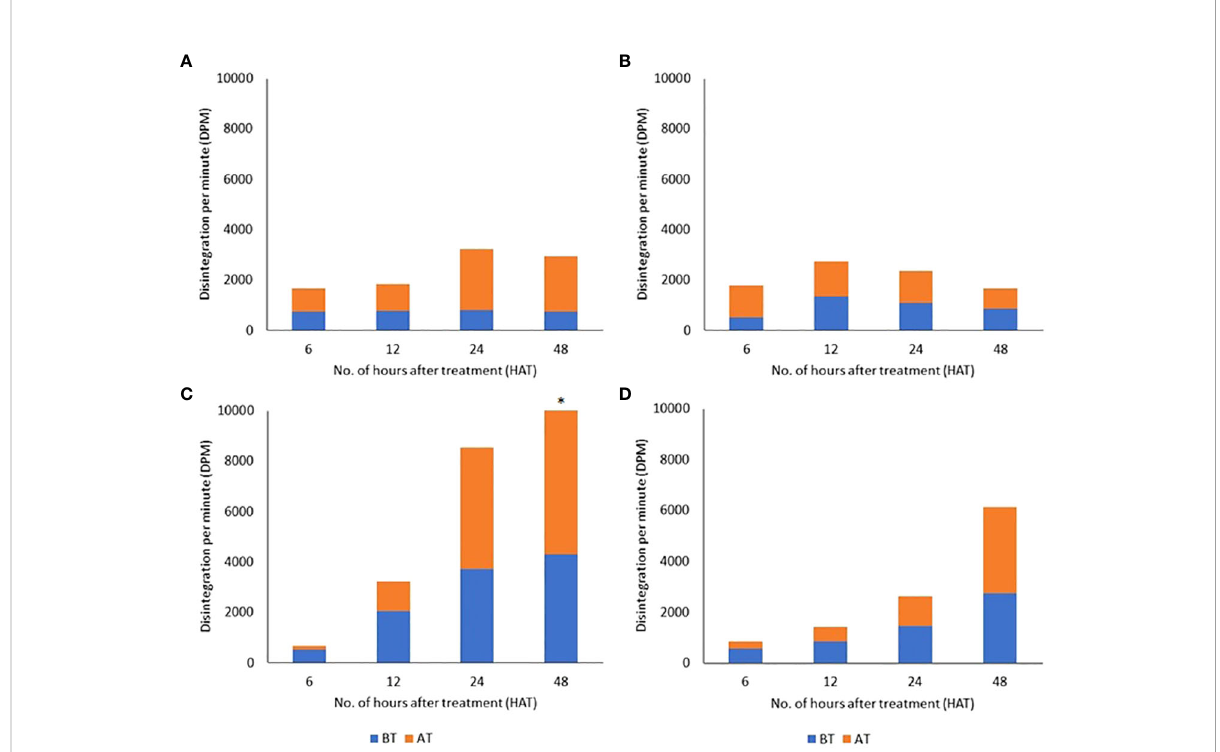
FIGURE 3 Distributions of [ 14 C]2,4-D detected in tissue fractions above the treated leaf (AT) and below the treated leaf (BT) in cotton seedlings of four genotypes: CS-T04-15 (A) , CS-T07 (B) , CS-B15sh (C) , and TM-1 (D) at 6 to 48 hours after treatment (HAT). Asterisk atop stacked bar indicates that the difference in radioactivity detected between AT and BT tissues was signi fi